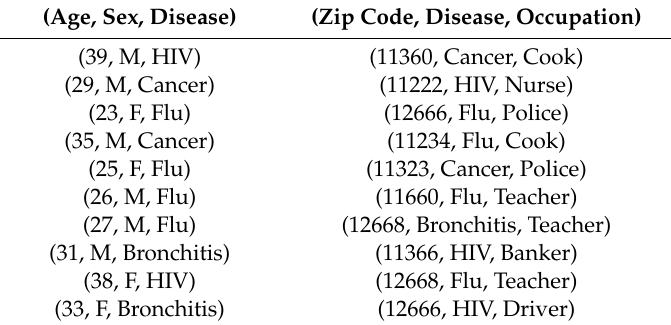
Table 13. Overlapped Slicing table with random